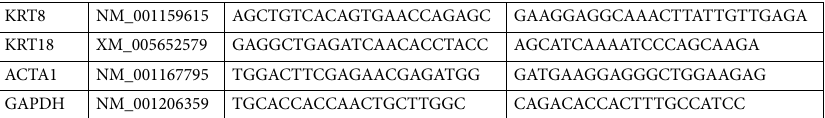
Table 3. Primer sequences of KRT8, KRT18 and